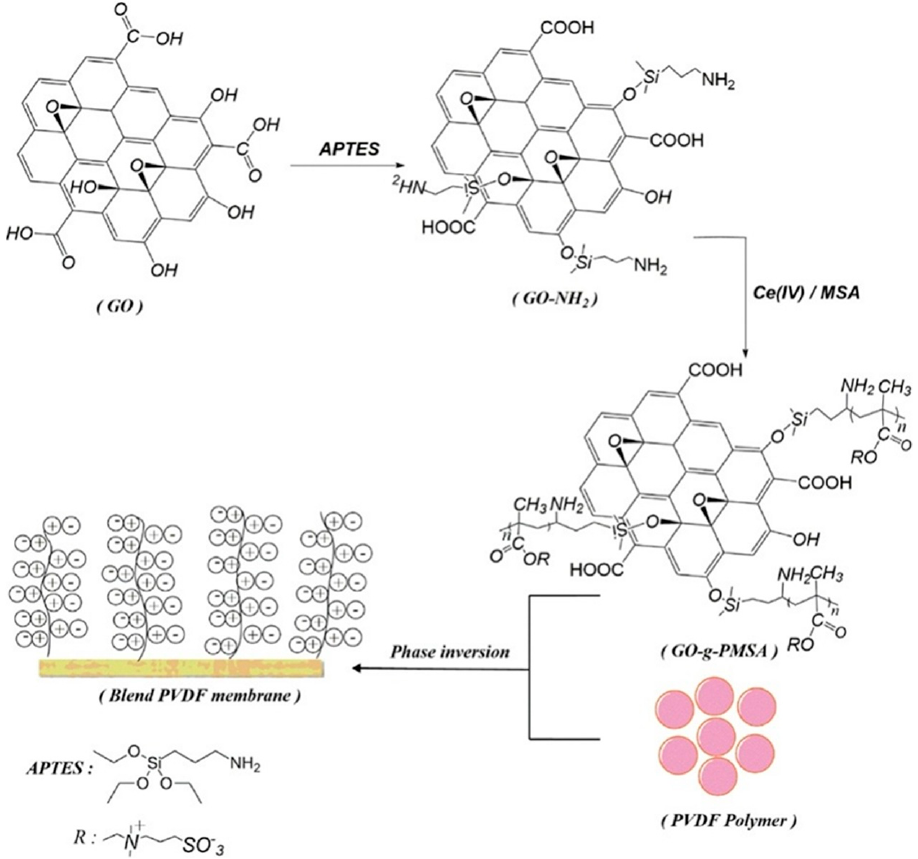
Figure 11. Scheme showing surface-instigated redox polymerization of 2 − (Methacryloyloxy) ethyl dimethyl − (3 − sulfopropyl) ammonium hydroxide from graphene oxide surface. Reprinted with permission from [94]. 2019, J. Water Process Eng.